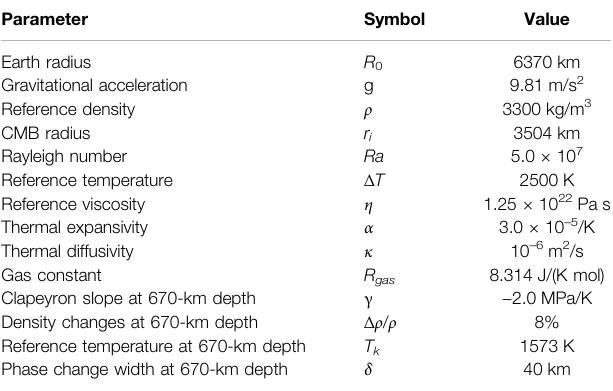
TABLE 1 | Physical parameters of numerical